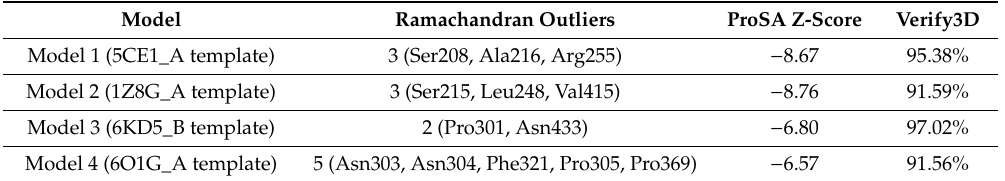
Table 2. Validation data for the four TMPS2 homology models.